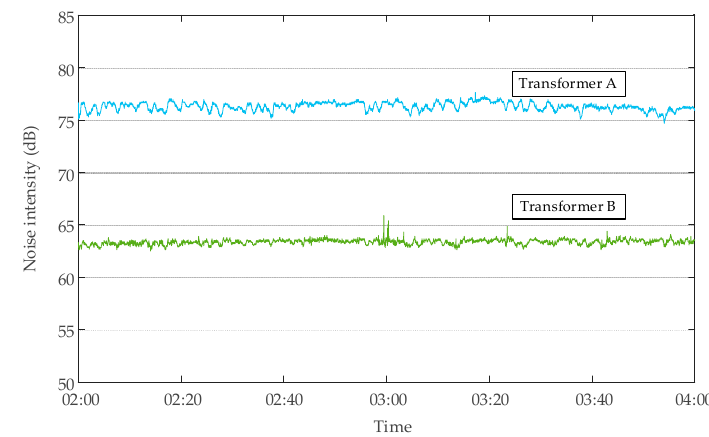
Figure 6. The noise intensity of transformer A and transformer B in the period from 2:00 to 4:00.